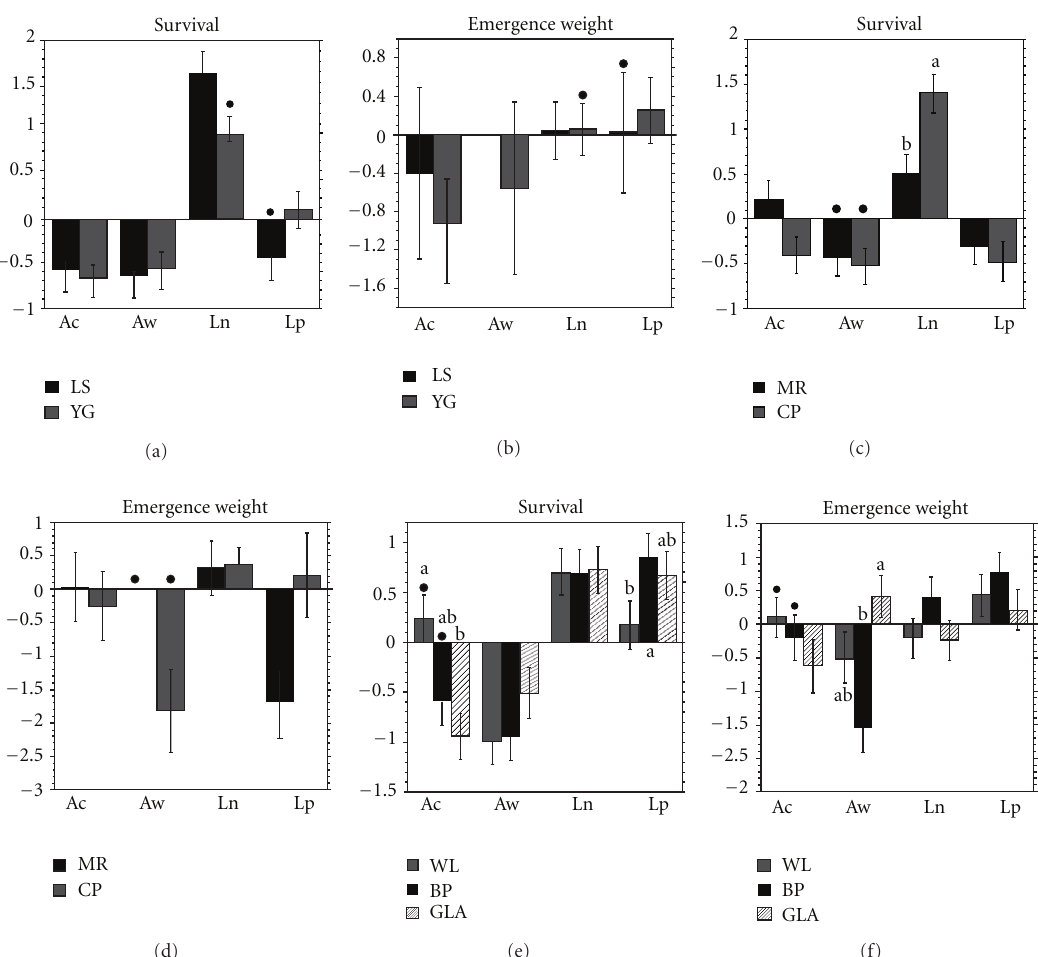
Figure 2: Survival and emergence weights from rearing experiments: (a and b) L. idas , (c and d) hybrid species, (e and f) L. melissa . Values are standardized ( Z transformed). Shading of bars indicates plant species; see legends and Figure 1 for population locations. See Table 2 for associated model details, including plant and population e ff ects. Significant di ff erences ( P < 0 . 05) for population e ff ects within plants are indicated here with small letters near bars. Black dots identify natal host associations for each population. Host plant abbreviations as follows. Ac; Astragalus canadensis ; Aw; Astragalus whitneyi ; Ln; Lotus nevadensis ; Lp; Lupinus polyphyllus . Results from alfalfa, M. sativa , are not shown here because survival was very low; see main text for